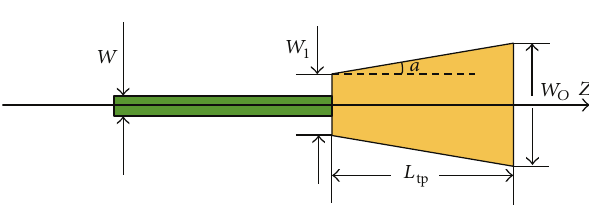
Figure 4: Contrast of single-channel output spectrum.